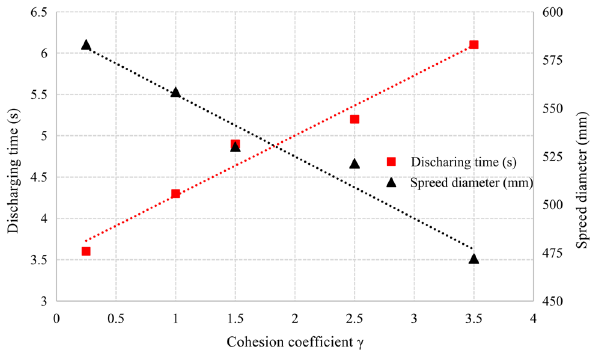
Figure 10: Variation curves of cohesion coe ffi cient, discharge time, and spread